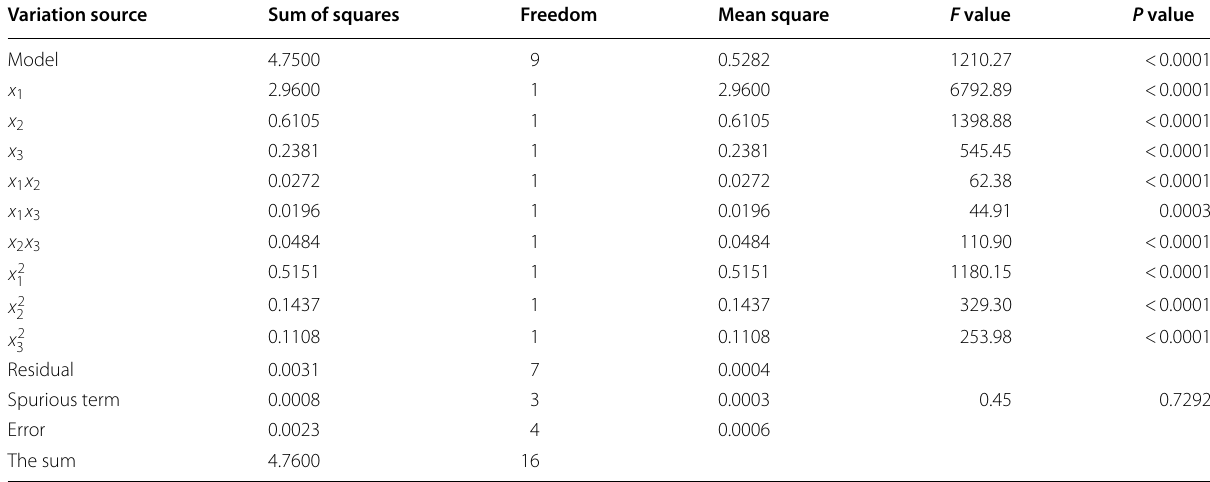
Table6 Variance analysis of surface roughness regression model Variation source Sum of